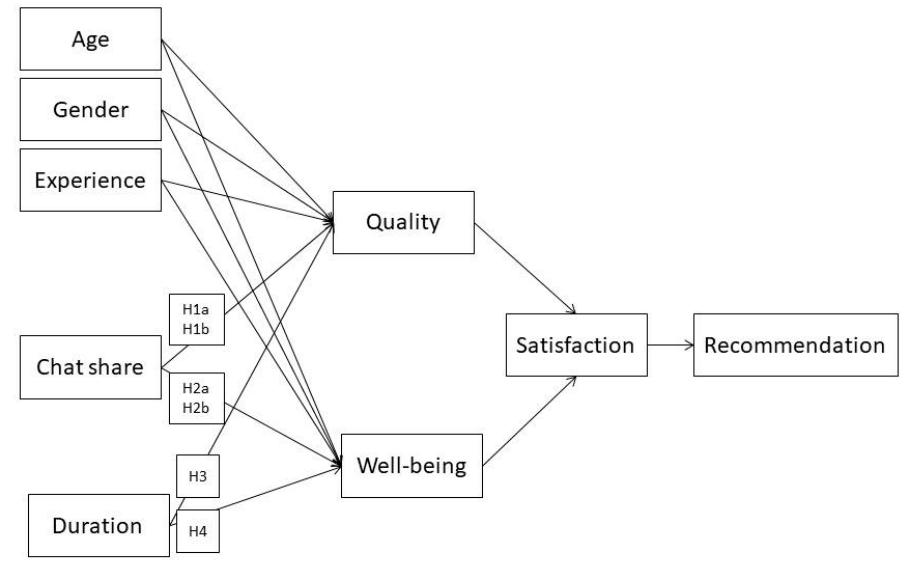
Figure 1. Hypothesized